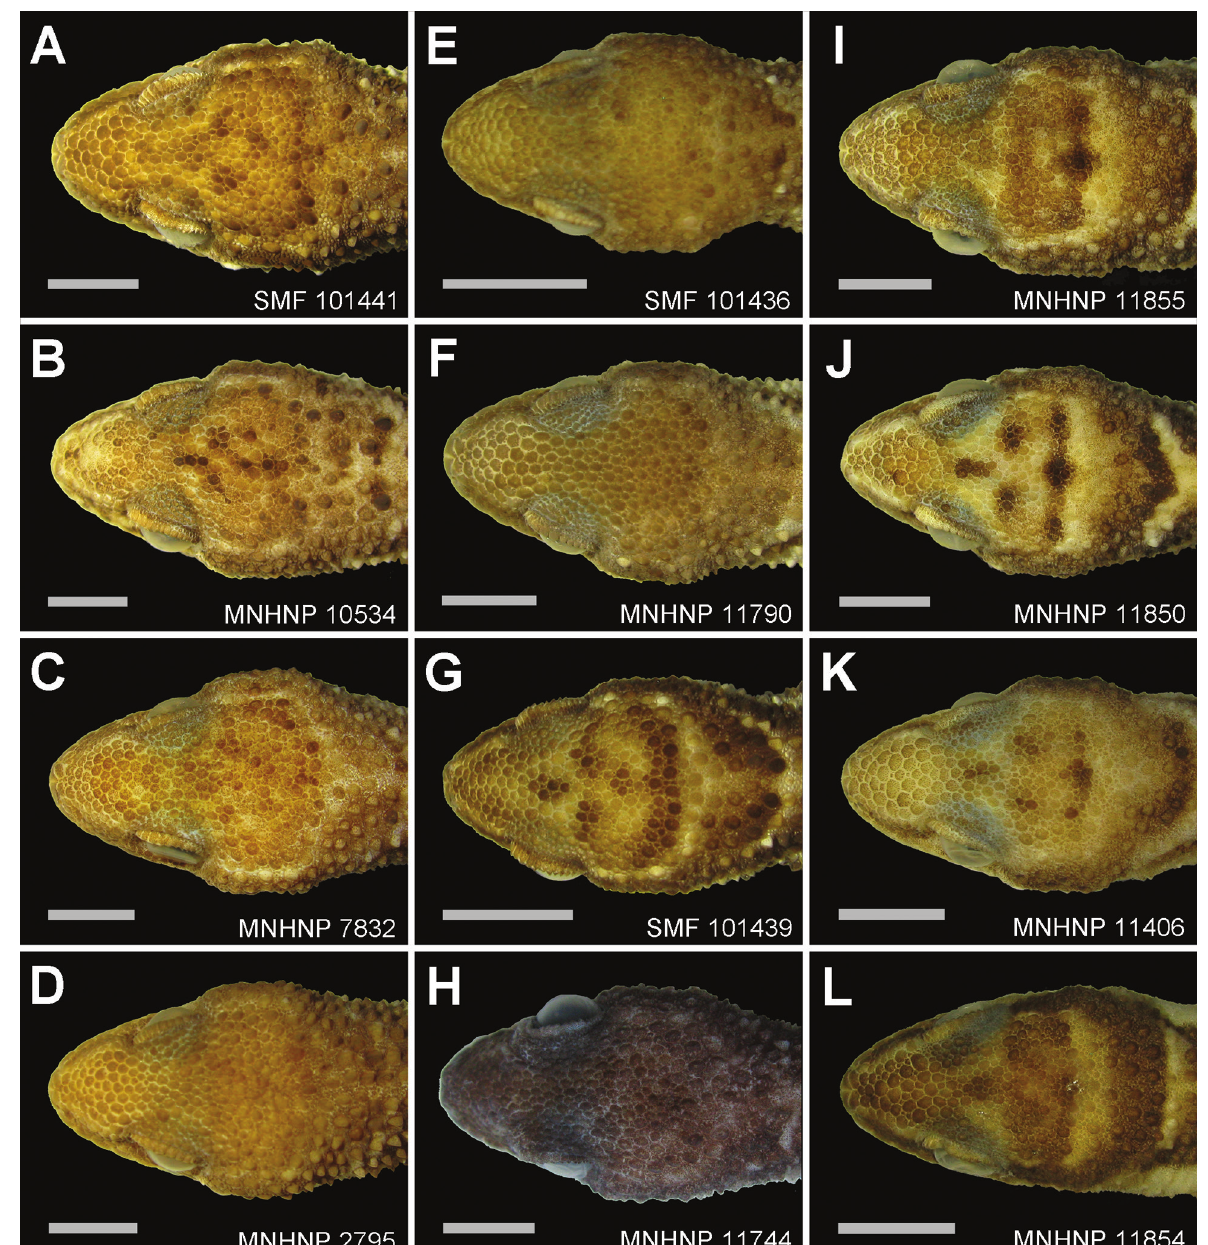
Figure 7. Variation in color patterns of Homonota marthae ( A – H ). The lack of the white occipital crescent-shaped line (present in H. septentrionalis , I – L ) is evident in most of the specimens. Scale bars: 5